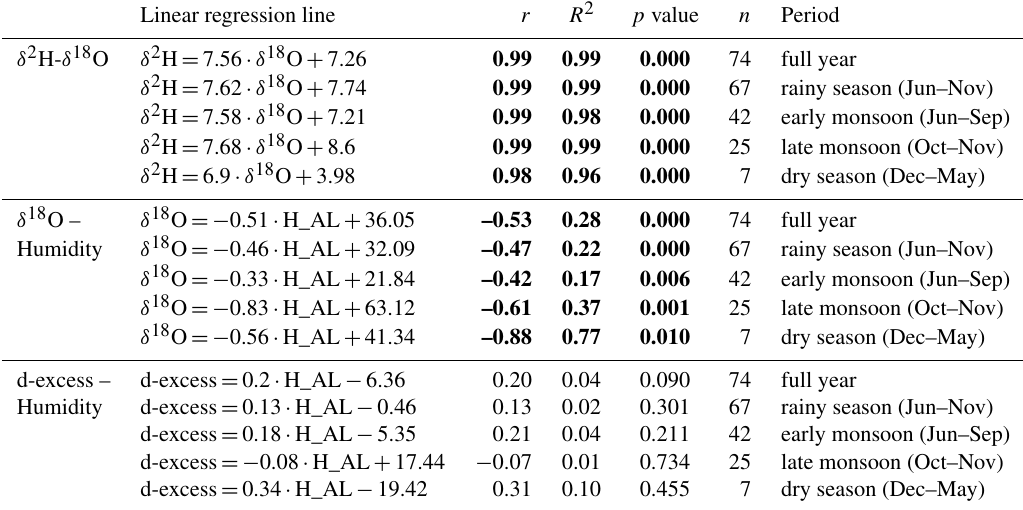
Table 3. Results of the linear regression analysis between local relative humidity (H_AL) and isotopic values at An Long. Regressions that are statistically significant at the 0.05 level are marked in